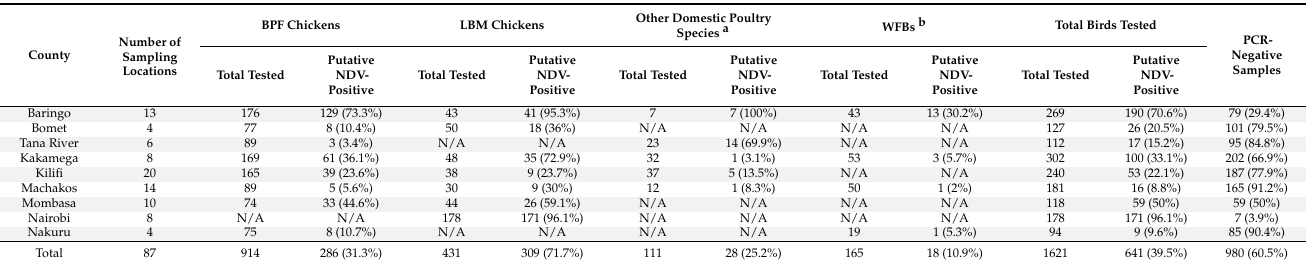
Table 1. Sources, number, and types of bird species collected at backyard poultry farms (BPFs) and live bird markets (LBMs) in nine Kenyan counties and considered as “putative Newcastle disease virus (NDV)-positive” based on the detection of NDV nucleic acids by the RRT-PCR L-test (cut off C T <